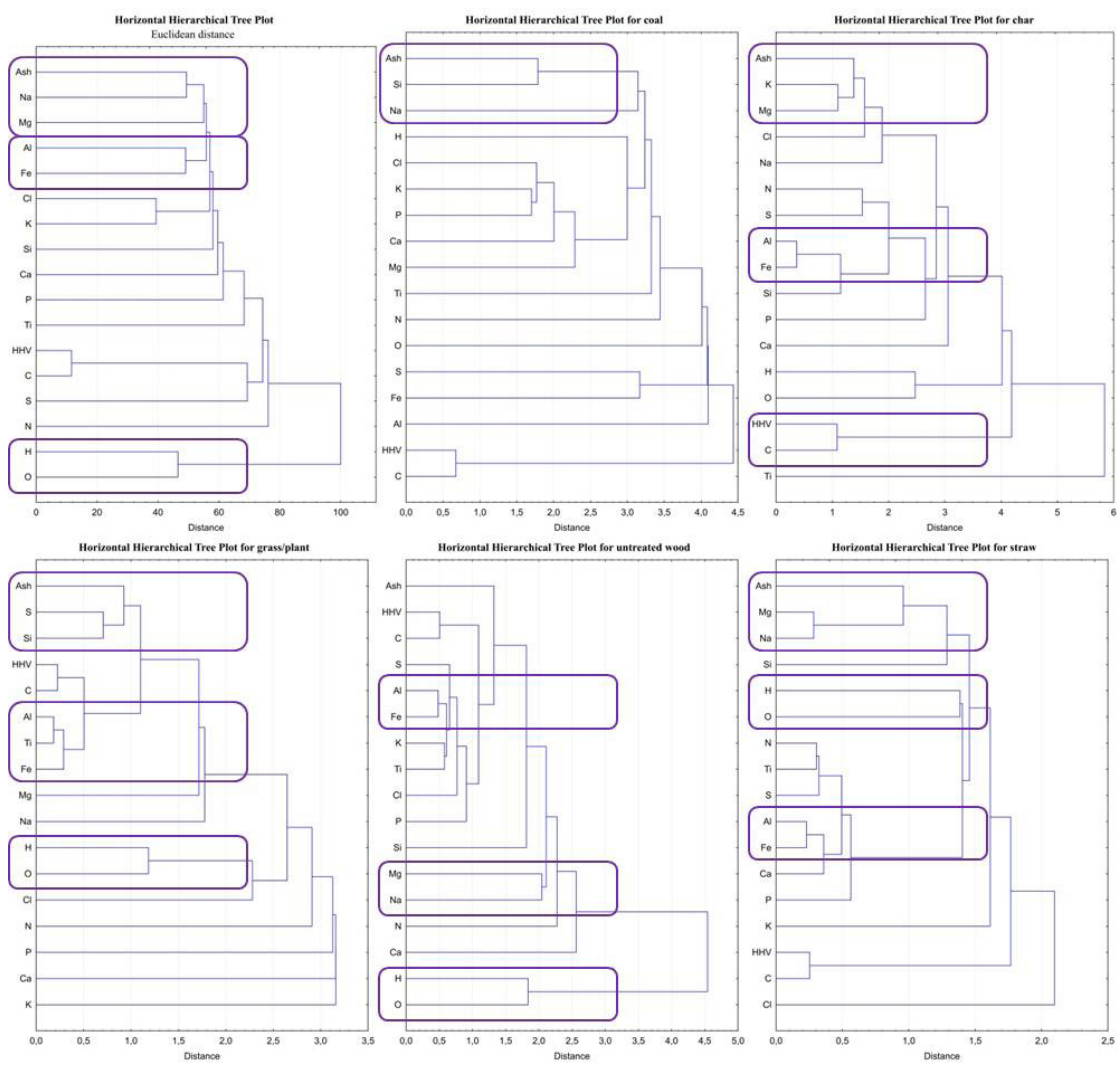
Figure 2. Horizontal Hierarchical Tree Plot for each type of test material (Ash - ash, HHV - enthalpy of